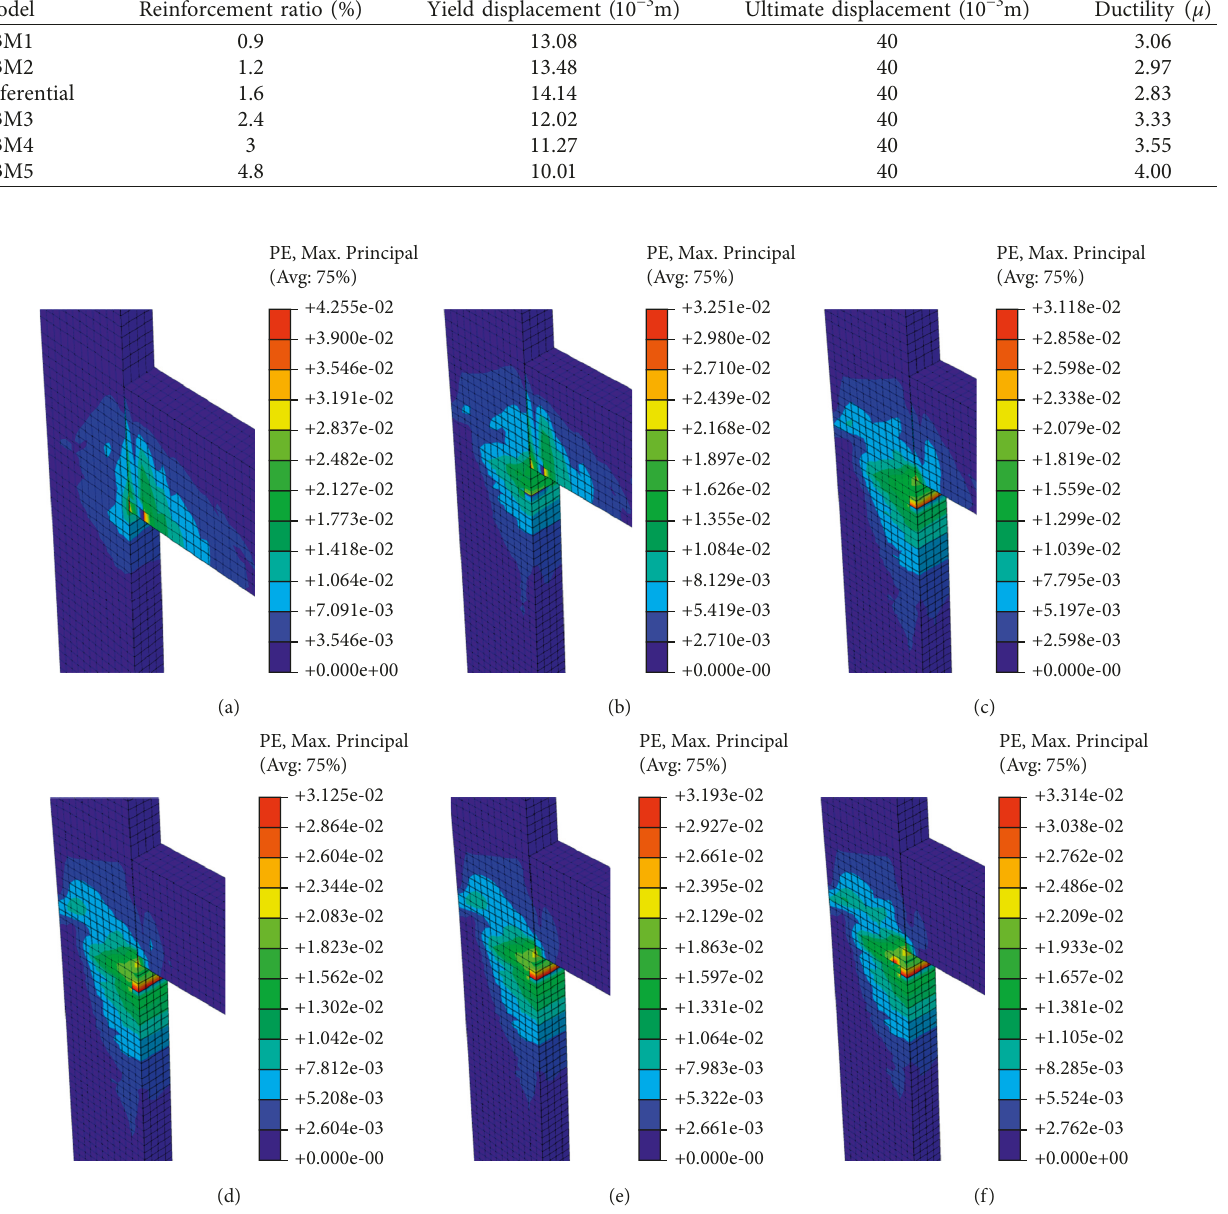
Figure 21: Crack pattern for specimens with various beam tensile reinforcement ratios: (a) G3M1, 0.9%; (b) G3M2, 1.2%; (c) Referential, 1.6%; (d) G3M3, 2.4%; (e) G3M4, 3%; and (f) G3M5,